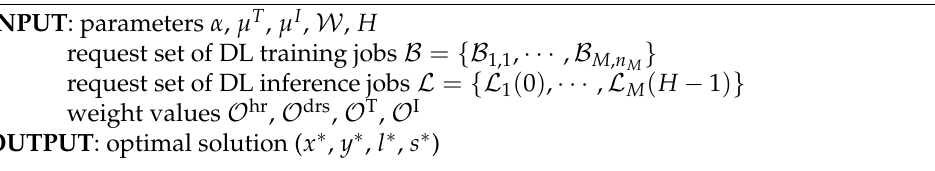
Algorithm 1 DL Job Allocation based on the CE-DLA